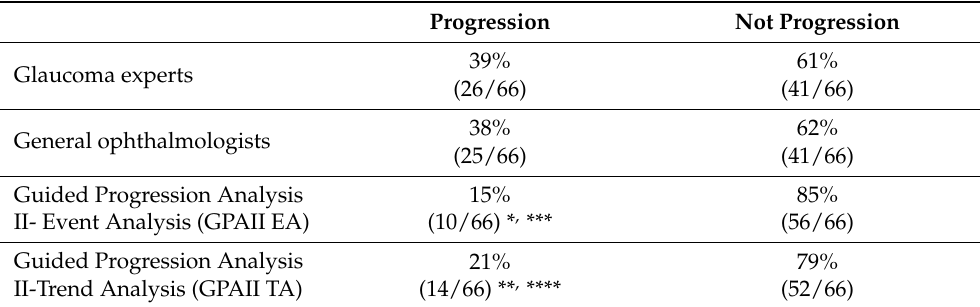
Table 1. Percentage of VF series with or without progression according to both glaucoma experts’ and general ophthalmologists’ evaluation and both GPAII event and trend